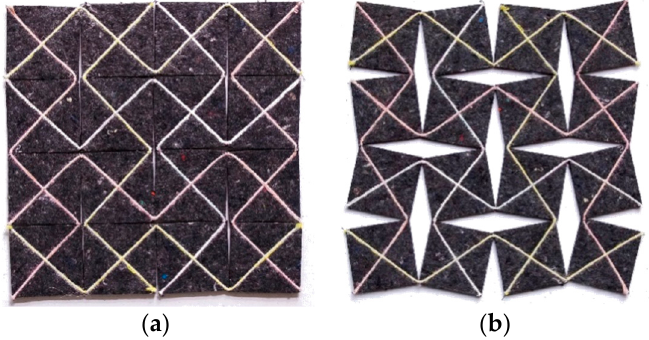
Figure 3. The moving squares of the textile Textile Reflexes in closed ( a ) and open ( b ) position. The Textile Reflexes material is made of separate squares. The square shape of the elements is optional, experiments were also done with more curved shapes, a combination of circles and ‘star’ shapes. The squares were finally chosen because they provide the most stable and strong material due to their equal, 90 ° angles. The squares are stitched together with a string across the diagonals, connecting each square to the next at the corners. This ensures that the corners remain a flexible point allowing the textile to grow, shrink, fold, and bend. No matter how big the basic squares are and , the opened textile has a breadth 1.4 ×